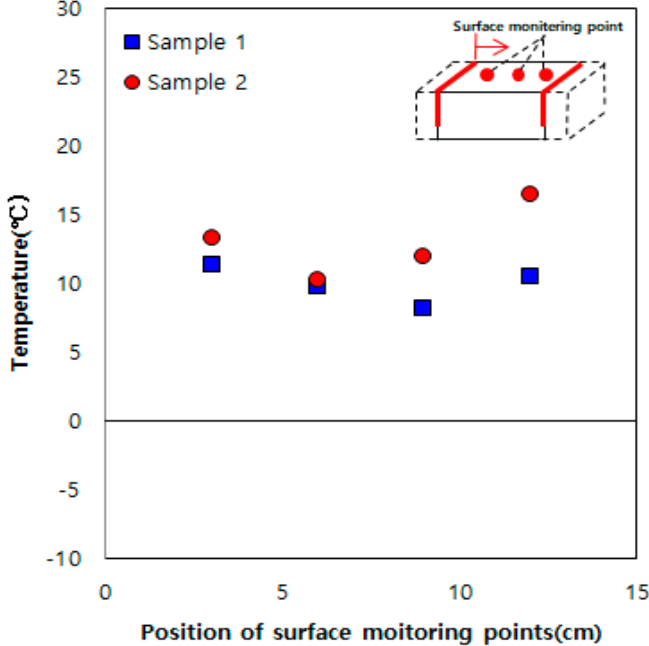
Figure 4. Results obtained using two heating elements spaced at 15 cm.